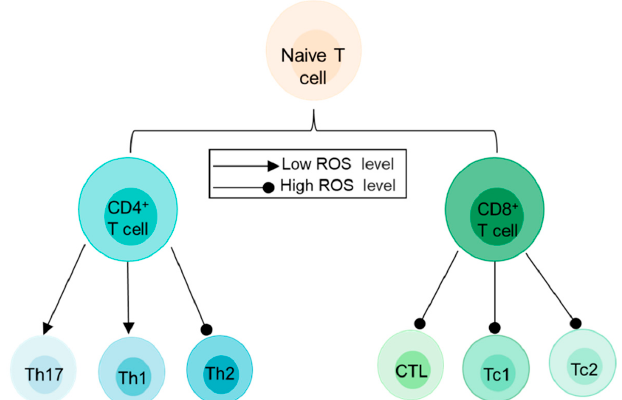
Figure 5. ROS play different roles in T-cell differentiation of different subpopulations. In naive CD4 + T cells, low levels of ROS may promote both Th1 and Th17 cell differentiation, while high levels of ROS promote the development of Th2 cells. After activation, naïve CD8 + T cells differentiate into mature CTL, Tc1 or Tc2 cells, when experiencing high levels of ROS.